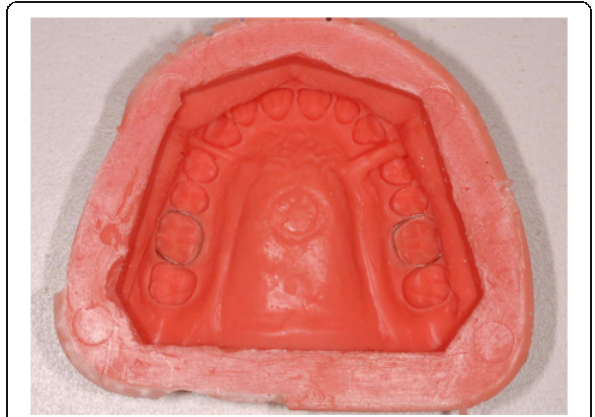
Fig. 3 Duplication of the master model in